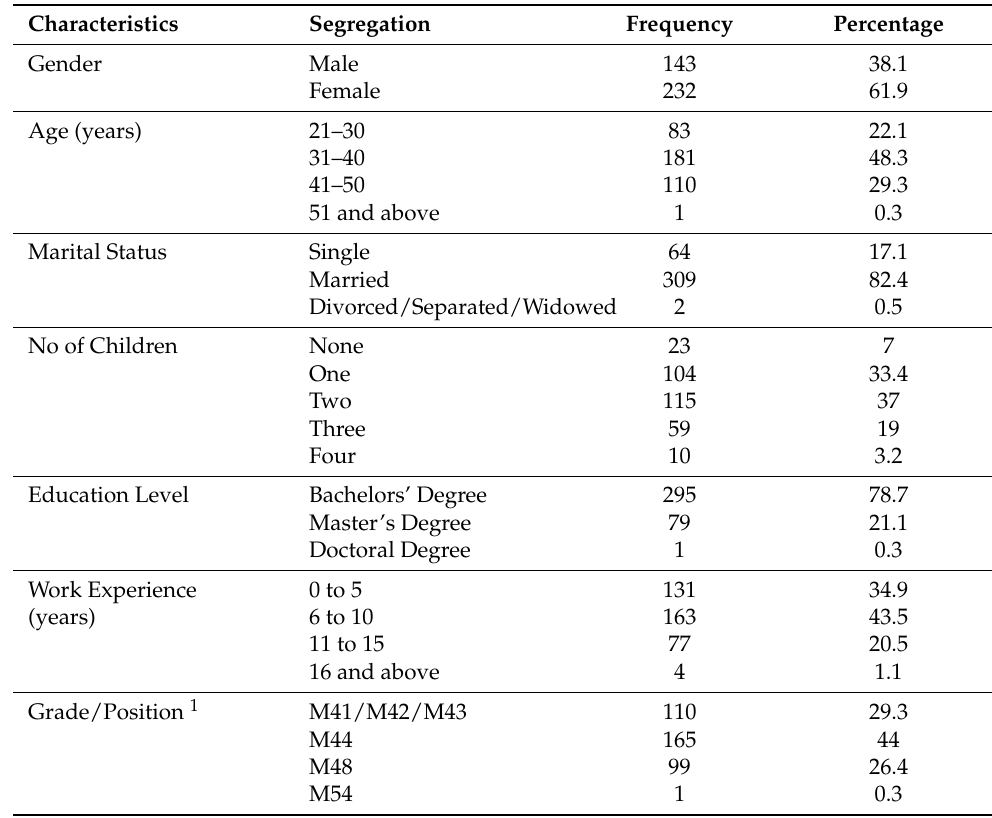
Table 2. Demographics of the Survey